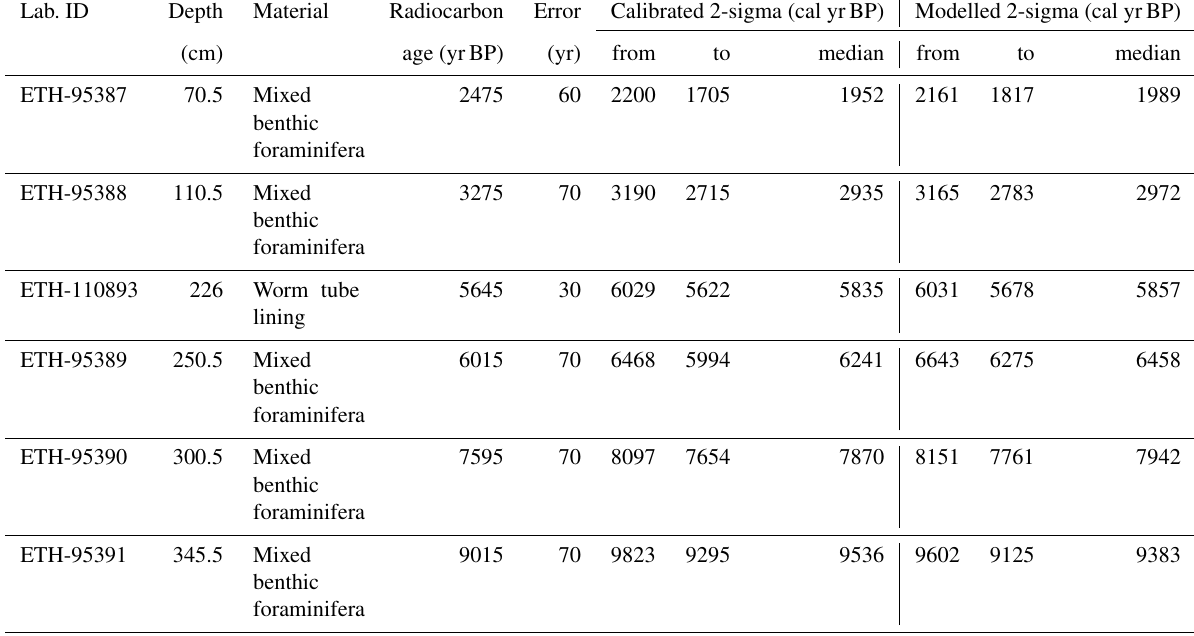
Table 1. List of radiocarbon dates and modelled ages in core DA17-NG-ST07-73G. All dates were calibrated using the Marine20 calibra- tion curve and (cid:49)R = 0 ± 50 years. Comparison between results from calibration with Marine20 and Marine13 is shown in Table A1 in Appendix